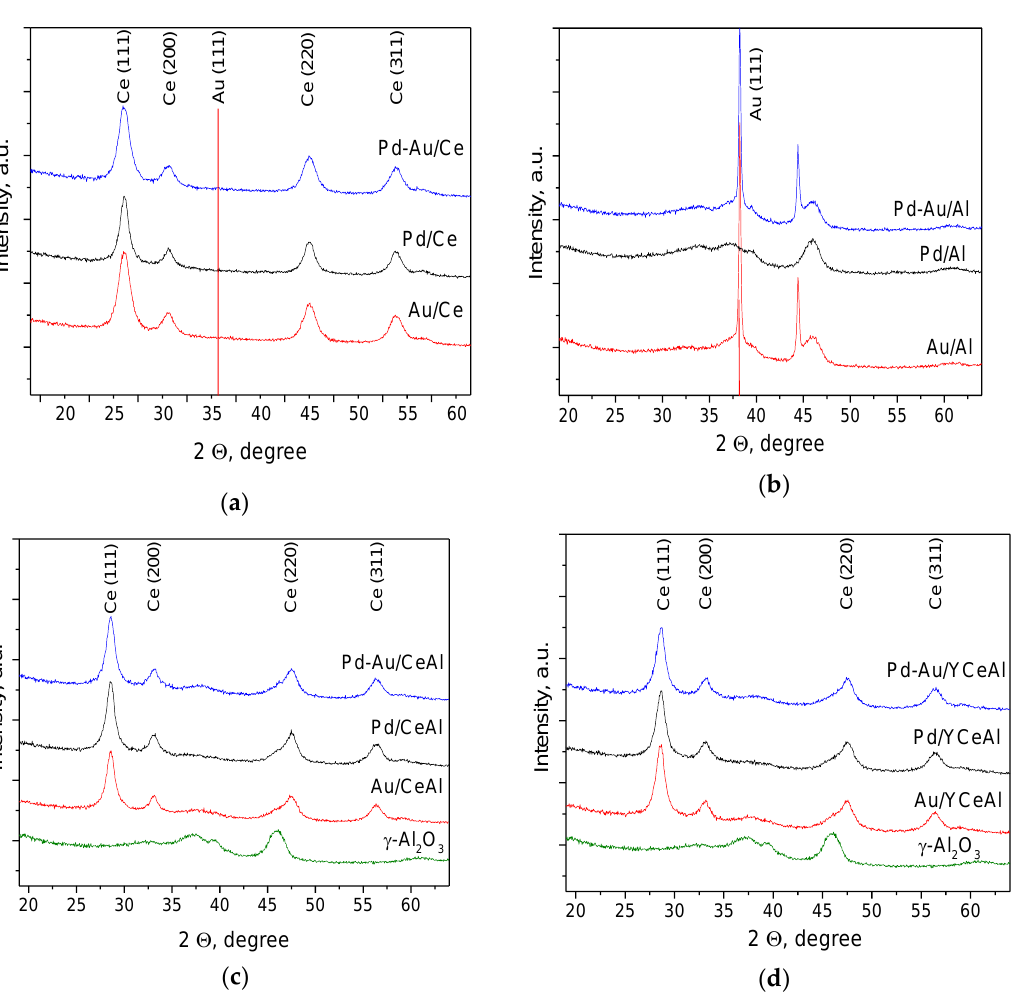
Figure 4. Powder X-ray diffraction (PXRD) patterns of mono- and bimetallic catalysts supported on: ( a ) CeO 2 ; ( b ) Al 2 O 3 ; ( c ) CeO 2 /Al 2 O 3 and ( d ) Y-doped CeO 2 /Al 2 O 3 .